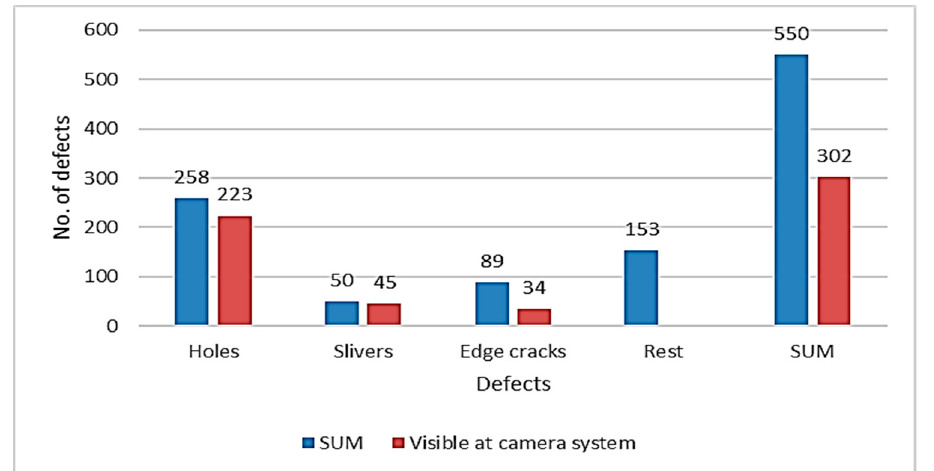
Figure 5. Result of defect verification.